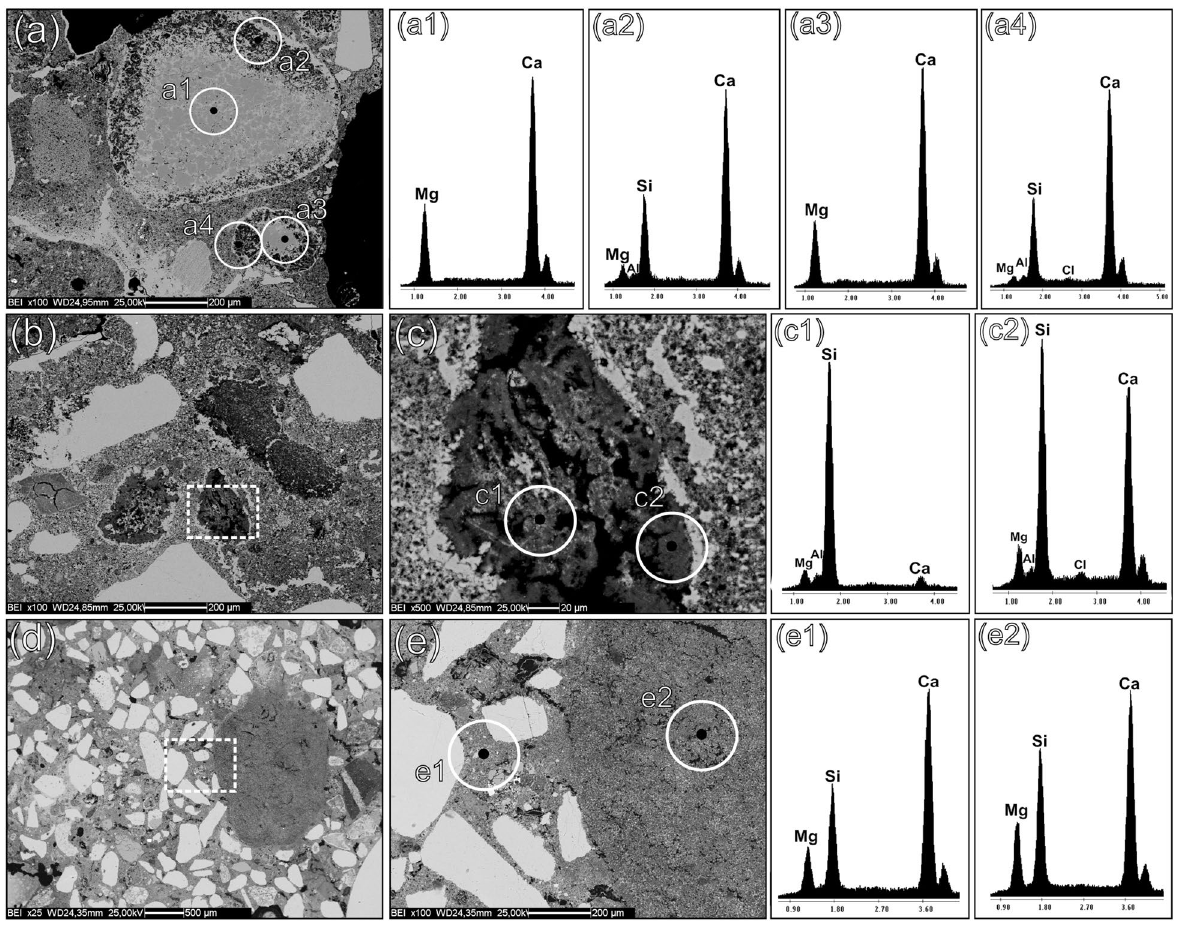
Figure 4. SEM–EDS analyses on representative samples of Group 1, showing reacted dolostones and chert clasts displaying the development of M-S–H gels. Backscattered electrons (BSE) acquisitions. ( a ) WM_3, altered clasts of dolostone; ( a1 ) EDS spectrum of the unreacted core of a dolostone clast; ( a2 ) EDS spectrum of the Mg-depleted rim of the clasts, with local enrichment in M–(A)–S–H; ( a3 ) EDS spectrum of the unreacted core of another dolostone clast; ( a4 ) EDS spectrum of the Mg-depleted rim of the clasts, with local enrichment in M– (A)–S–H; ( b ) WM_3, altered clasts of chert; ( c ) magnification of the dashed area at fig. ( b ); ( c1 ) EDS spectrum of a feebly altered core of a clast of chert; ( c2 ) EDS spectrum of a reacted area of the clast, indicating a local development of M–(A)–S–H and a likely occurrence of C–S–H through reaction with the lime component; ( d ) PREF_12, lime matrix of the sample with a lime lump on the right; ( e ) magnification of the dashed area in fig. ( d ); ( e1 ) EDS spectrum of an area of the binder matrix displaying M–S–H development; ( e2 ) development